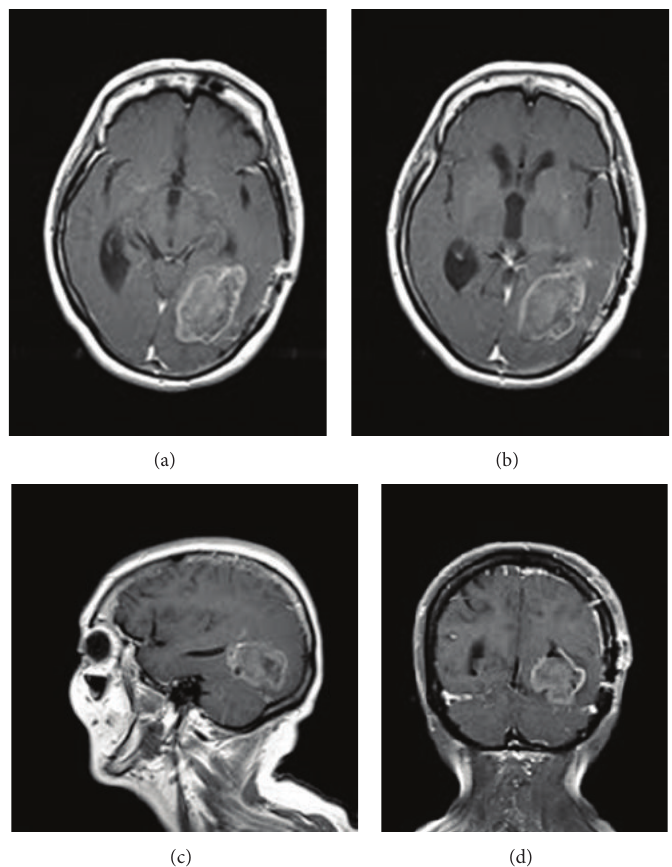
Figure 3: Brain MRI at second admission. (a), (b) Axial T1-weighted image with gadolinium, showing a larger mass with peripheral enhancement compared to the original appearance of the lesion as seen in Figure 1. (c) Sagittal T1-weighted image with gadolinium, showing the larger lesion with a more substantial intraparenchymal component. (d) Coronal T1-weighted image with gadolinium also shows the enlarged lesion with greater mass effect.